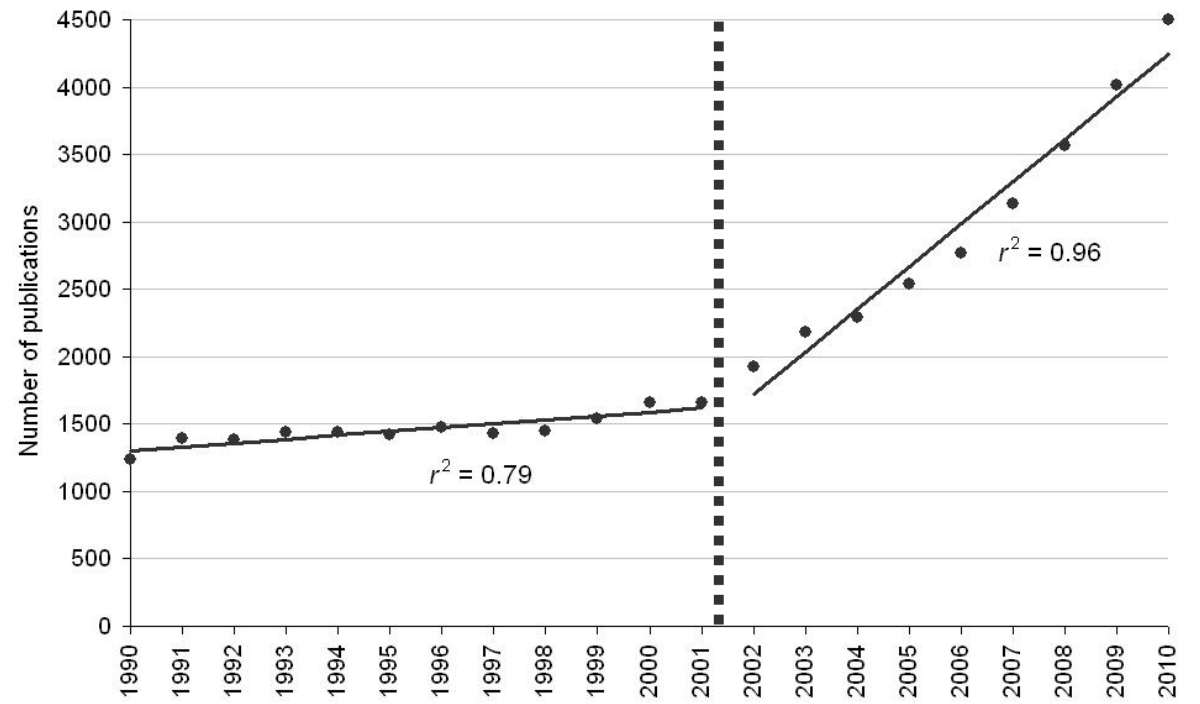
Figure 1. Total number of publications in military medicine by year of